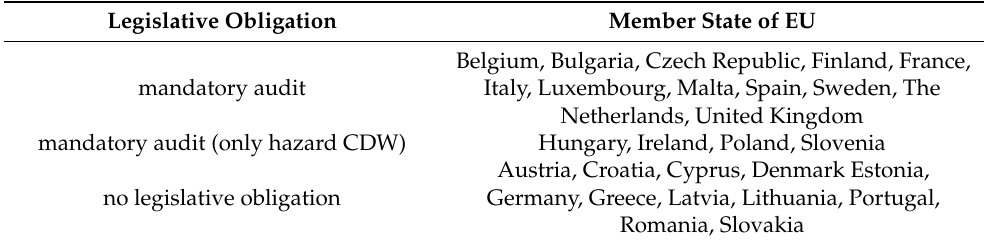
Table 5. Legislative obligation for construction and demolition waste audit [38–40].